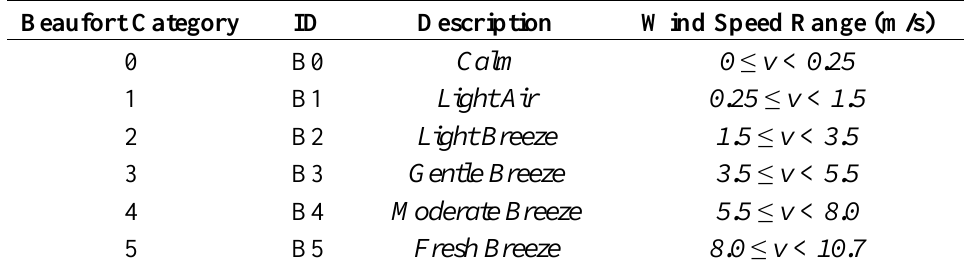
Table 4. First six categories of the Beaufort